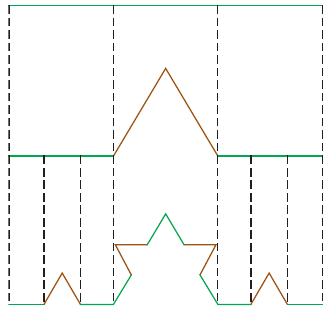
Figure 1: Koch curve construction based on Koch generator, orders 0, 1, and